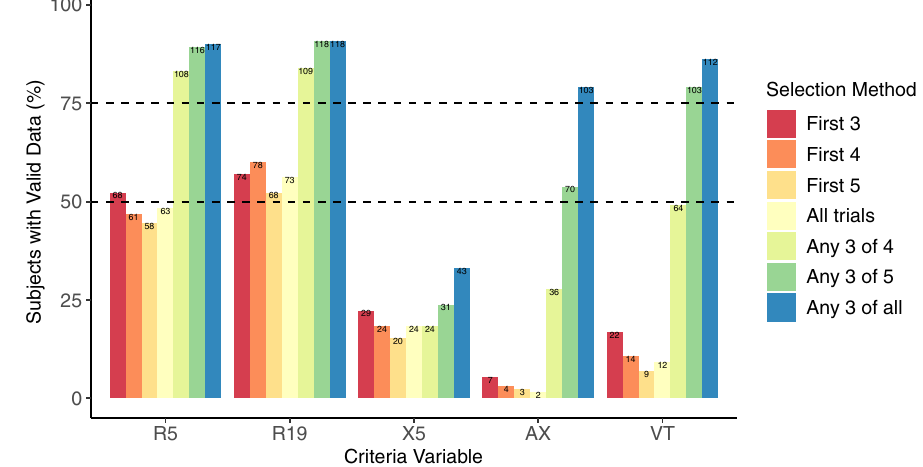
Figure 1. Proportion of subjects with valid data as a function of selection method. Percent (y-axis) and number (top of bars) of subjects able to achieve valid data for each selection method and criteria combination across both sessions. The percentages are out of a total of 129 (number of subjects attempting trials in both sessions). Valid data refers to trials passing three levels of quality assurance: ( 1 ) software checks, ( 2 ) investigator checks, and ( 3 ) session validity following trial selection and application of the thresholding criteria variable (CoV ≤ 10%). Reference lines (black dashed lines) are drawn at 50% and